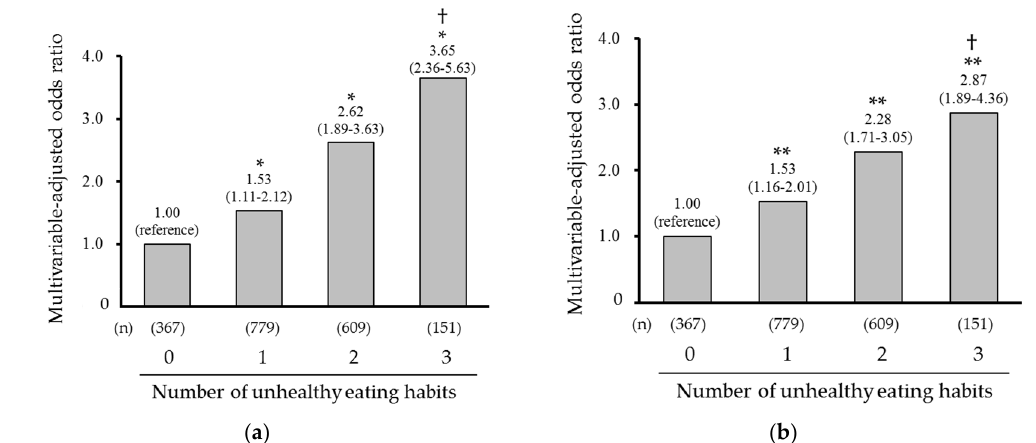
Figure 2. Multivariable-adjusted odds ratio of obesity and central obesity according to the number of accumulated unhealthy eating habits: ( a ) Obesity; ( b ) Central obesity. The values on the bars show the odds ratios (95% confidence intervals), which were adjusted for age, sex, current smoking, current drinking, regular exercise, marital status, living status, and employment status. * p < 0.05, ** p < 0.01 vs. “0”, † p for trend < 0.001.